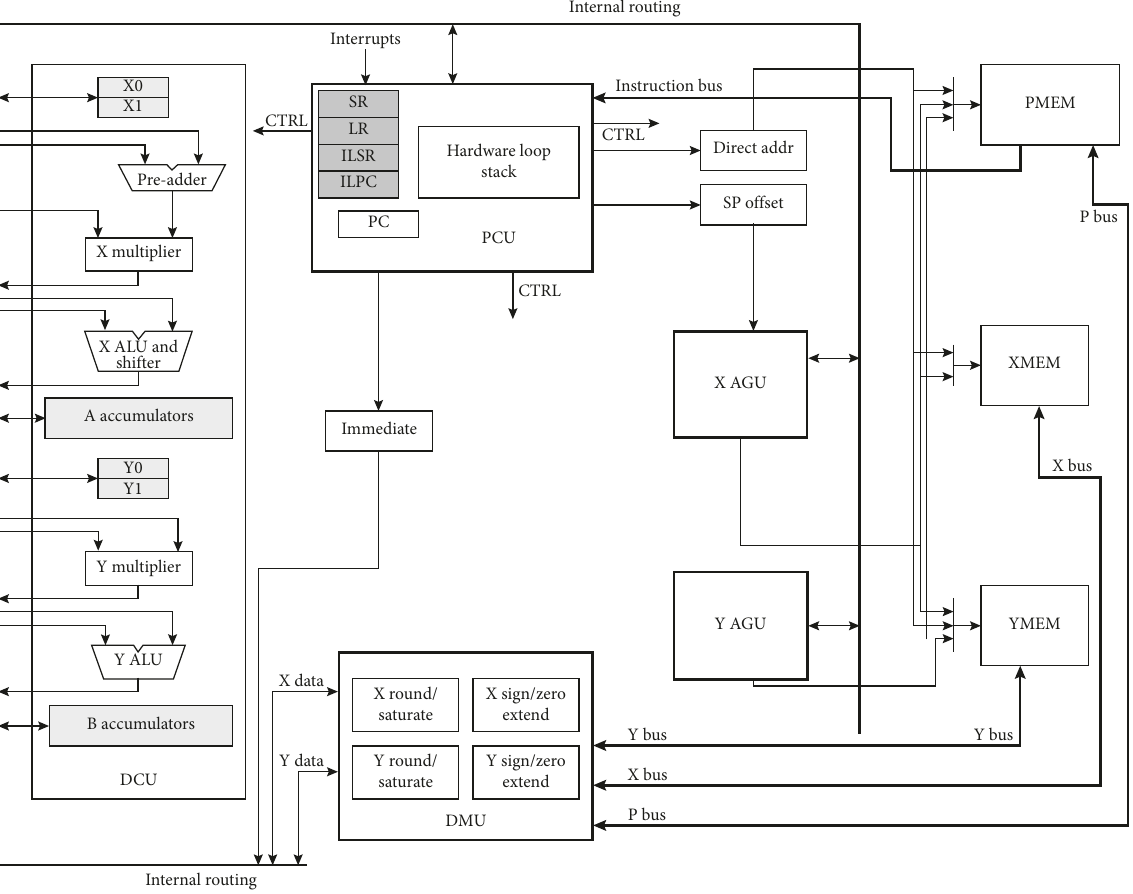
Figure 9: CFX DSP core